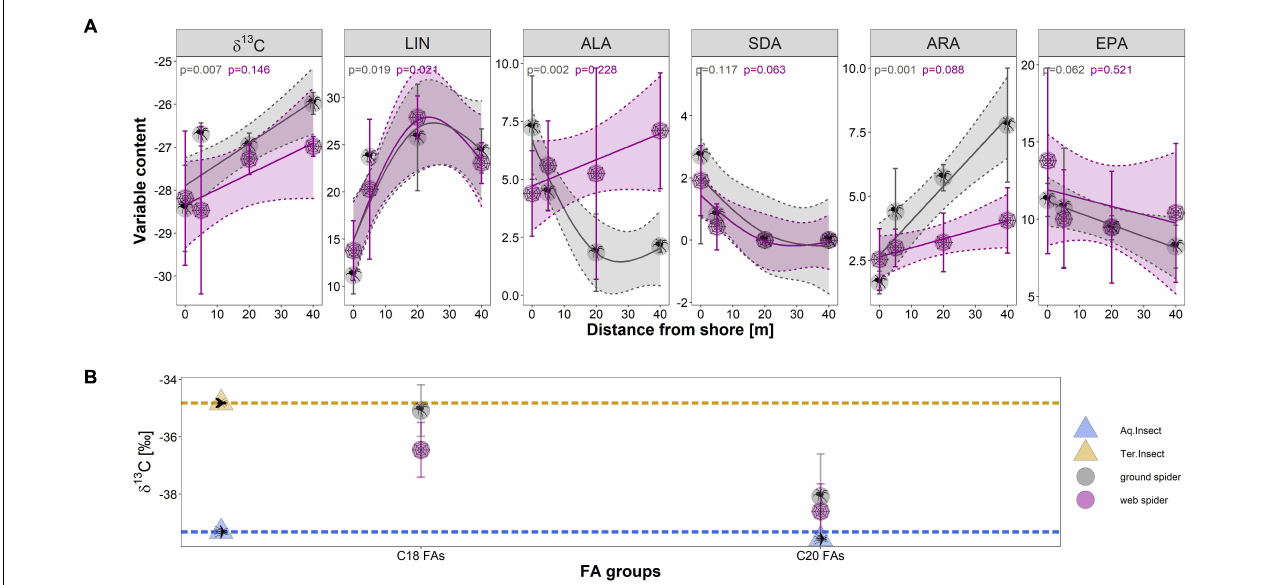
FIGURE 7 | (A) The relationship in δ 13 C and the different measured PUFAs (as % of total fatty acids) with distance from stream shore at site N4 (Necker) in June (per distance n = 3; except web spider 20 m, n = 2) for web spiders and ground spiders; (B) Compound-specific carbon stable isotope ratios ( δ 13 C) of combined C18 fatty acids and combined C20 fatty acids for web spiders ( n = 3) and ground spiders ( n = 3). Dashed lines represent average aquatic (blue) and terrestrial (orange) C18 fatty acids carbon isotope ratios. Symbols represent mean carbon isotope value for each group and error bars represent standard